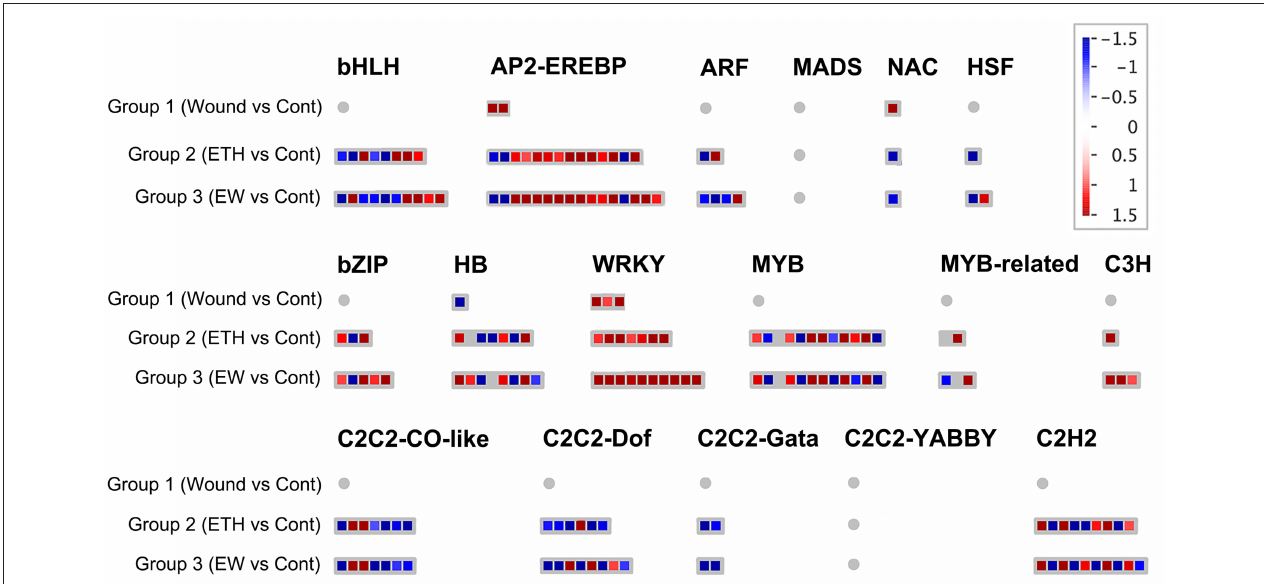
FIGURE 3 | Display of differentially expressed genes related to transcription factors. Significant DEGs (fold changes ≥ 2 and adjusted p -value ≤ 0.05) were organized into functional categories (BINs) (Thimm et al., 2004) and visualized by MapMan software (version 1.0). The color set scale was placed on the top right, and the gene expression increased is indicated in red and decreased in blue. Detailed information on gene expression is listed in Supplementary Table 3 .